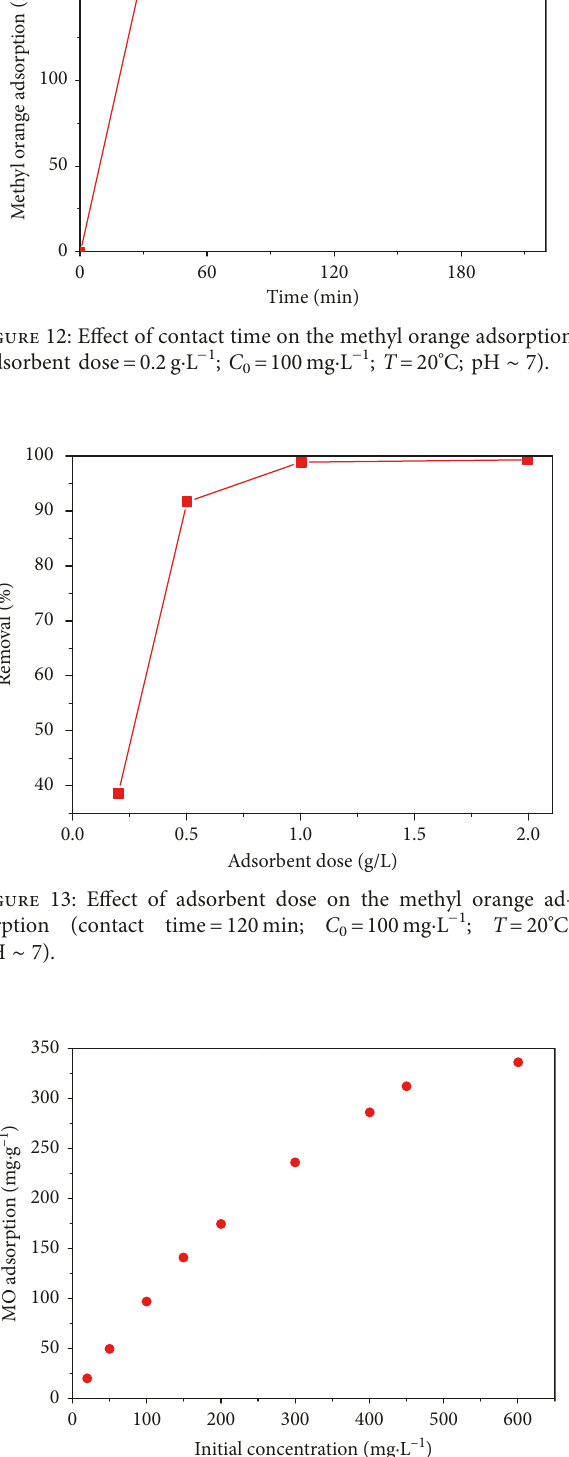
Figure 14: Effect of initial methyl orange concentration on the methyl orange adsorption (contact time � 120min; adsorbent dose � 1 g · L − 1 ; T � 20 ° C; pH ∼ 7).